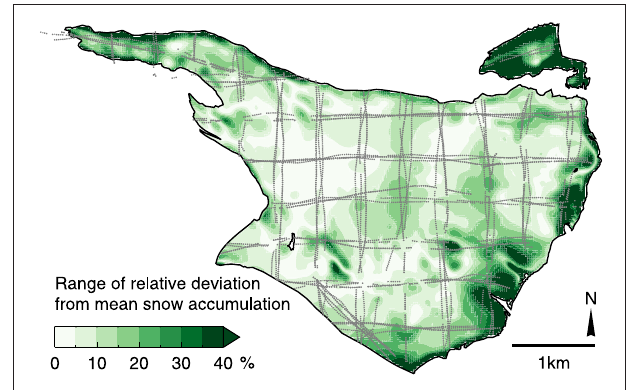
FIGURE 9 | Temporal variability of the snow accumulation pattern shown as the range of the relative deviation (in %) from the normalized snow accumulation distribution averaged over 2012–2014. Gray dots show GPR measurements of the same